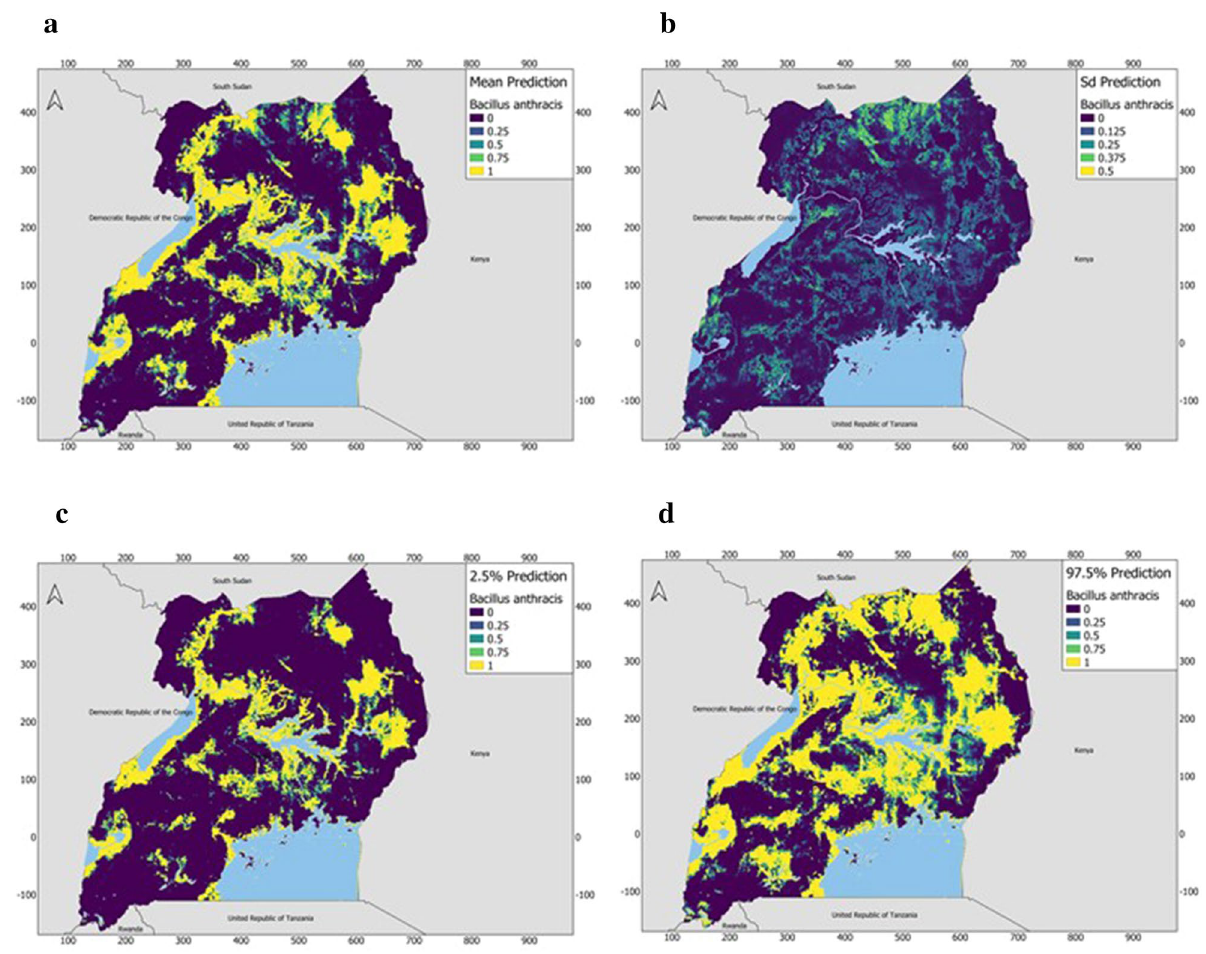
Figure 4. ( A ) The posterior predictive mean ( B ) posterior standard deviation ( C ) posterior lower credible interval (2.5% quantile) and ( D ) posterior credible upper interval (97.5% quantile) of the probability of B. anthracis suitability across Uganda from wildlife data (2004–2010). Prediction maps were developed using the Quantum Geographic Information System software (QGIS). URL: https:// qgis. osgeo. org